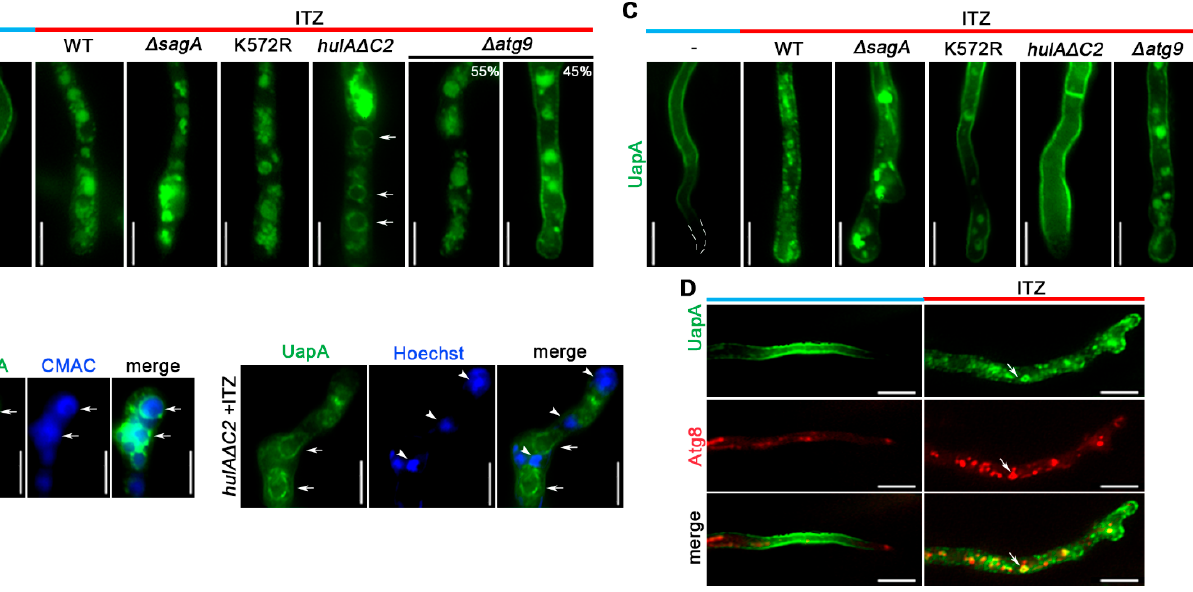
Figure 5. Turnover of UapA in response to ITZ in different genetic backgrounds related HulA-dependent endocytosis and selective autophagy. Details on growth conditions are identical to those described in the legend of Figure 3. In ( A ) notice that the effect of ITZ on de novo UapA localization, basically its mislocalization to cytosolic structures, was observed in all genetic backgrounds, although in a fraction of Δ atg9 we could still detect PM labeling by UapA. Biological/technical replicates: 2/150 for each strain. ( B ) Co-localization of UapA-GFP with CMAC (vacuoles) or Hoechst (nuclei-indicated with arrow heads) confirmed that the membranous rings (arrows) observed mostly in hulA Δ C2 , correspond to vacuolar membranes rather than perinuclear ER. Biological/technical replicates: 2/15 for each condition. ( C ) Notice the full (in hula Δ C2 ) or partial (in UapA-K572R or Δ atg9 ) protection of PM pre-localized UapA from endocytic turnover. Biological/technical replicates: 2/120 for each strain. ( D ) Co-localization analysis of UapA-GFP with mCherry-Atg8 in response to ITZ addition. Notice that in the presence of ITZ, Atg8-labelled structures became more evident all over the cytoplasm and develop into hollow autophagic structures (highlighted with an arrow), and that these forms co-localize significantly with internalized UapA. Biological/technical replicates: 2/50. Unless stated otherwise, the images shown represent the outcome observed in 100% of cells examined. Scale bars: 5 μ m.